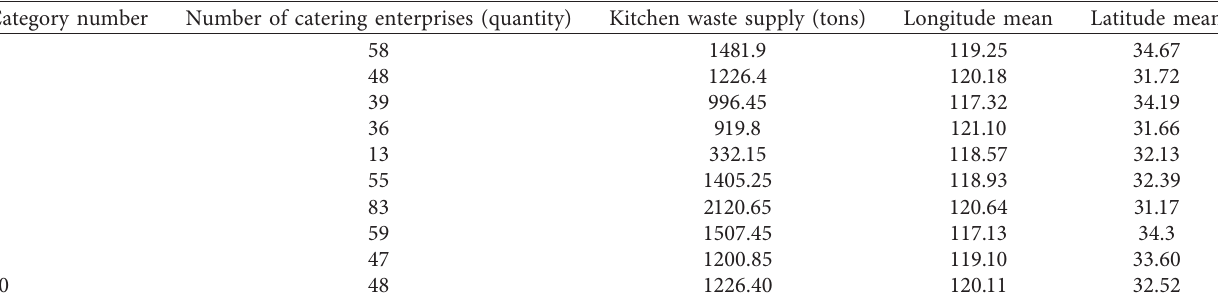
Figure 4: Food and beverage enterprises in Jiangsu Province kitchen waste supply Table 2: Regional basic information of catering enterprises in Jiangsu Province.